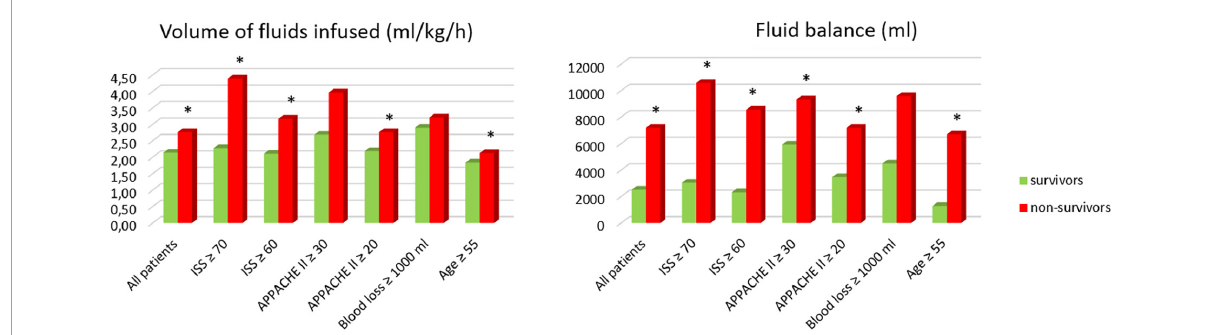
FIGURE2 Comparison between survivors and non-survivors. ∗ Results statistically